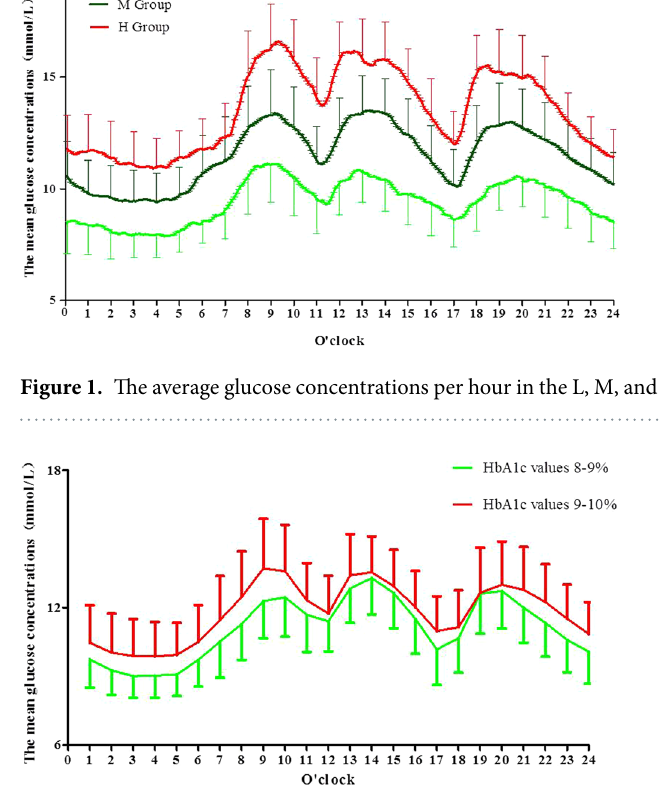
Figure 2. The average glucose concentrations per hour in patients with HbA 1c values from 8% to 10%.